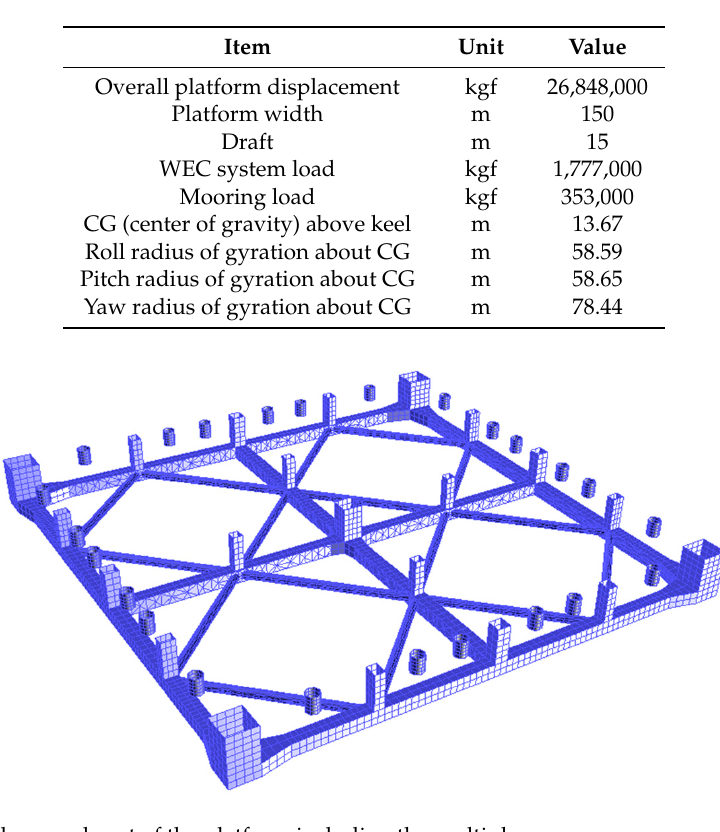
Figure 2. Submerged part of the platform including the multiple wave energy converters (WECs). Table 1. Platform